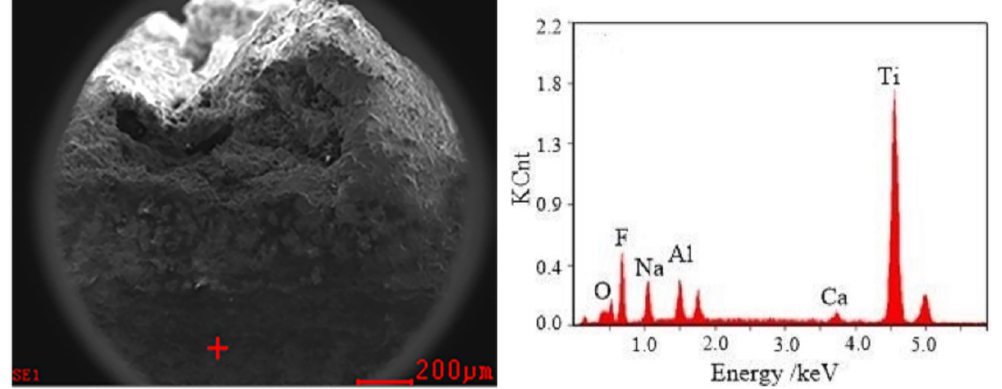
Figure 11. Cross section and EDS spectrum of coating after corrosion.